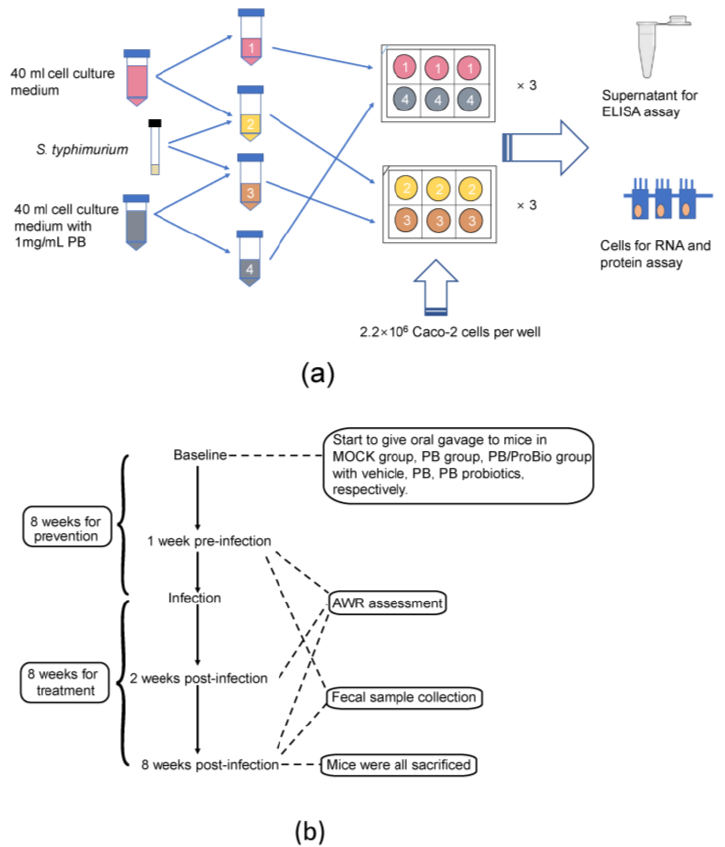
Figure 1. The schematic diagram of ( a ) Caco-2 cells experiment and ( b ) mice model experiment.